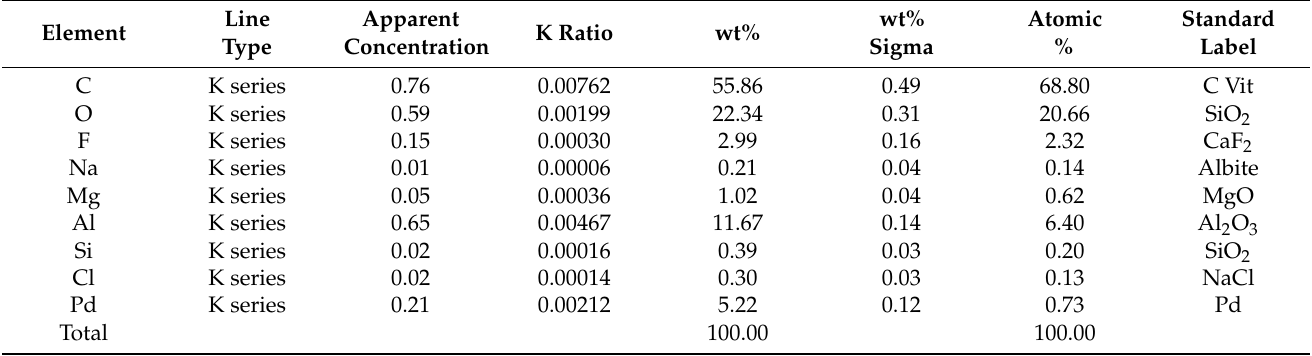
Table 12. The results of EDS